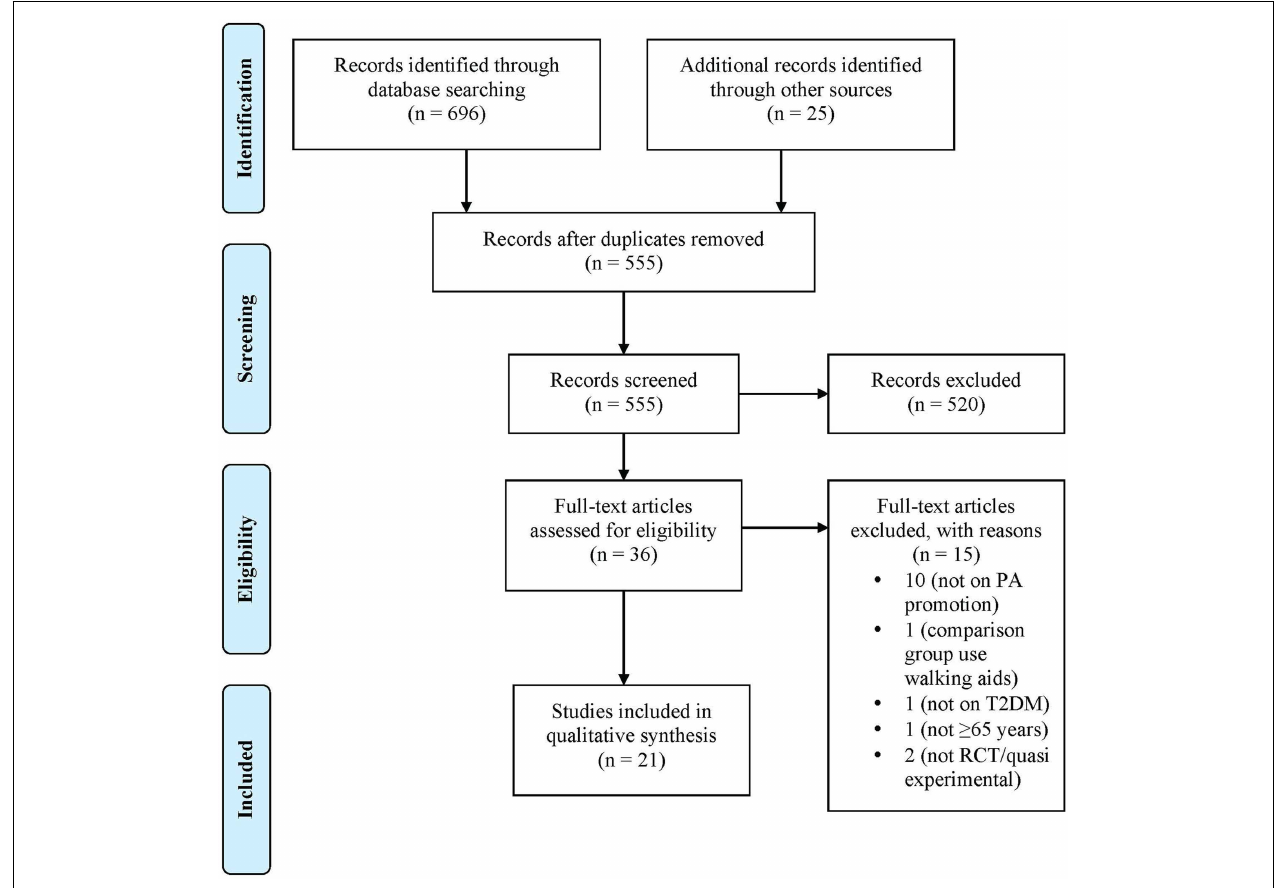
FIGURE 1 | Flow diagram for study selection according to PRISMA (19)